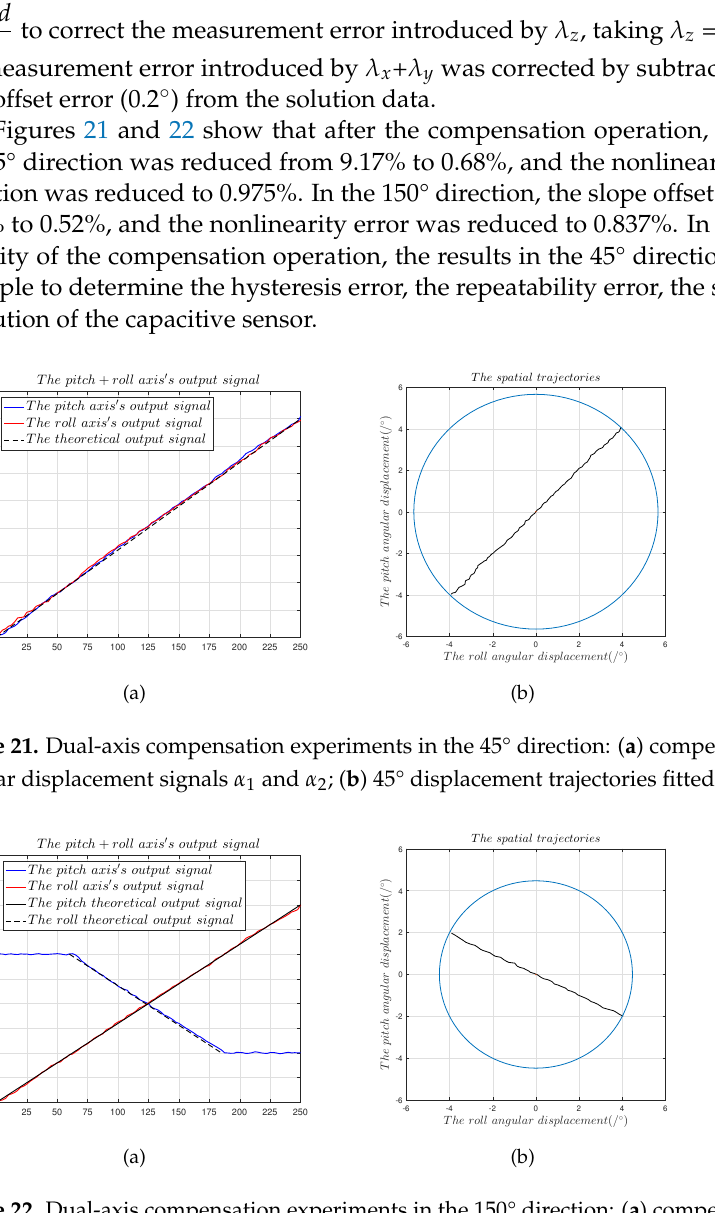
Figure 22. Dual-axis compensation experiments in the 150° direction: ( a ) compensation results of the angular displacement signals α 1 and α 2 ; ( b ) 150° displacement trajectories fitted by α 1 and α 2